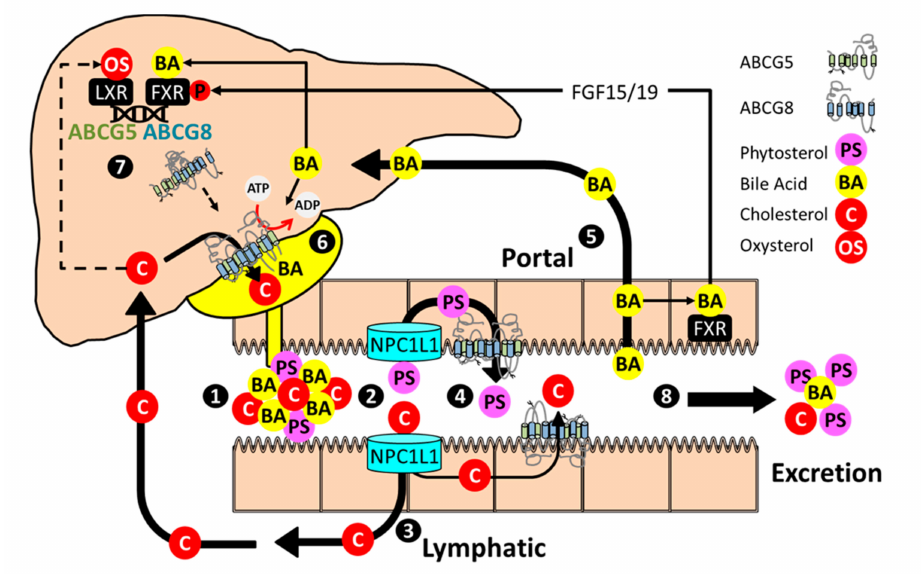
Figure 1. Enterohepatic sterol flux and regulation of ABCG5 ABCG8 . (1) Bile acid micelles facilitate the solubilization of dietary and endogenous sterols in the proximal small intestine. Phospholipids not depicted. (2) NPC1L1 facilitates uptake of cholesterol and phytosterols into intestinal enterocytes (3) Cholesterol is incorporated into chylomicrons, delivered to the plasma compartment through the lymphatic system, and cleared by the liver. ABCG5 ABCG8 also promotes cholesterol secretion into the intestinal lumen. (4) Phytosterols are poorly absorbed and largely returned to the intestinal lumen by ABCG5 ABCG8. (5) Bile acids are reabsorbed in the distal small intestine, stimulate